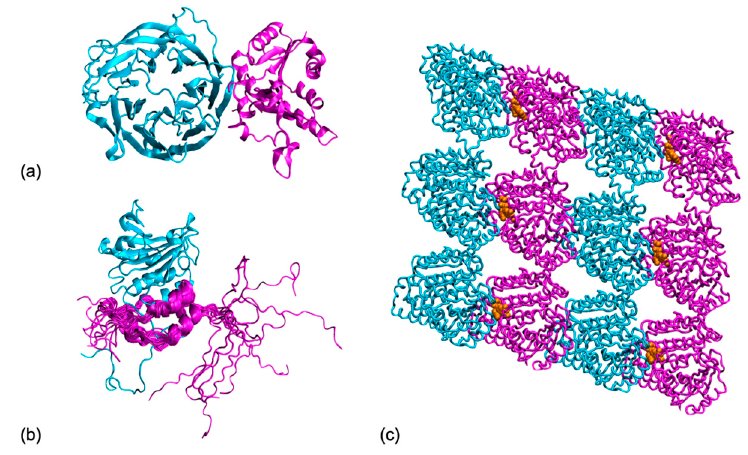
Figure 2. Protein interfaces take many shapes. Looking at their dynamic properties can bring us precious information on their function: ( a ) A protein complex with fully folded partners, target 29 from the CAPRI score-set [119], tRNA m7G methylation complex from yeast (pdb code 2vdu) with the catalytic unit Trm8 (in cyan) and its partner Trm82 (in magenta); ( b ) A protein complex comprising disordered regions, p150 unit from the eukaryotic initiation factor 4F (in magenta) folds upon binding the translational initiation factor A4 (in cyan), but its N-terminal tail remains disordered (pdb 1rf8); ( c ) A protein complex with active interfaces, cryo-EM structure of a microtubule fragment with GDP (in orange) bound at the interface between the tubulin α (in cyan) and β (in magenta) chains. (pdb 3j6f). All graphical representations were made with VMD [95].